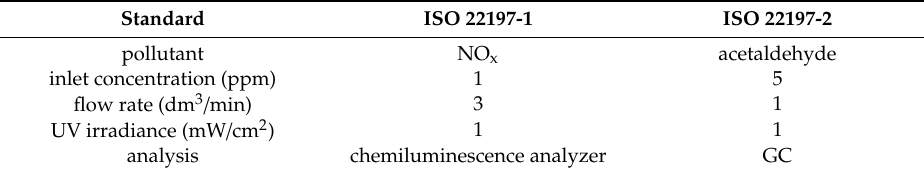
Table 2. Experimental conditions of performed